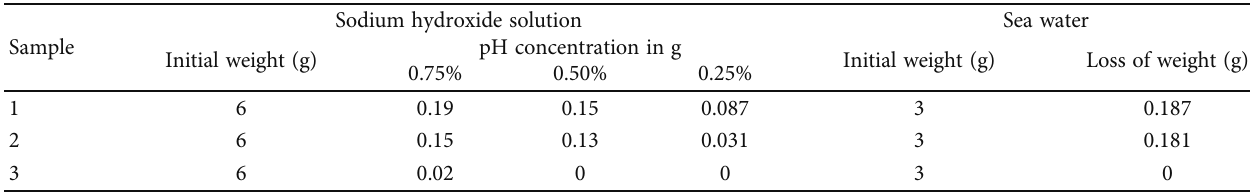
Figure 5: (a) Potentiodynamic analysis of corrosion results on sample 1. (b) Potentiodynamic analysis of corrosion results on sample 2. (c) Potentiodynamic analysis of corrosion results on sample 3. Table 4: Corrosion test